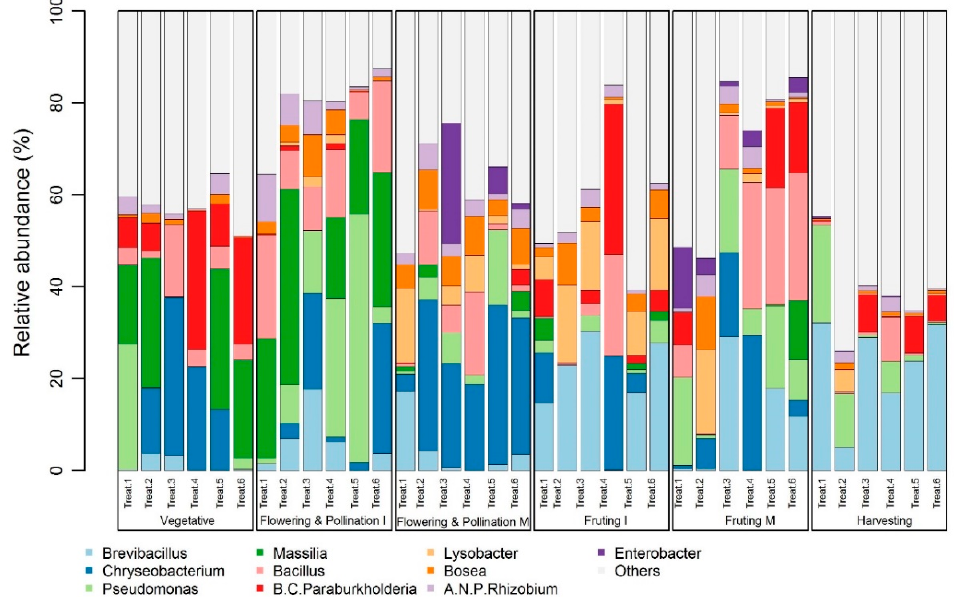
Figure 5. Change in dominant rhizosphere bacterial taxa at the genus level across different nutrient treatments and melon growth stages.